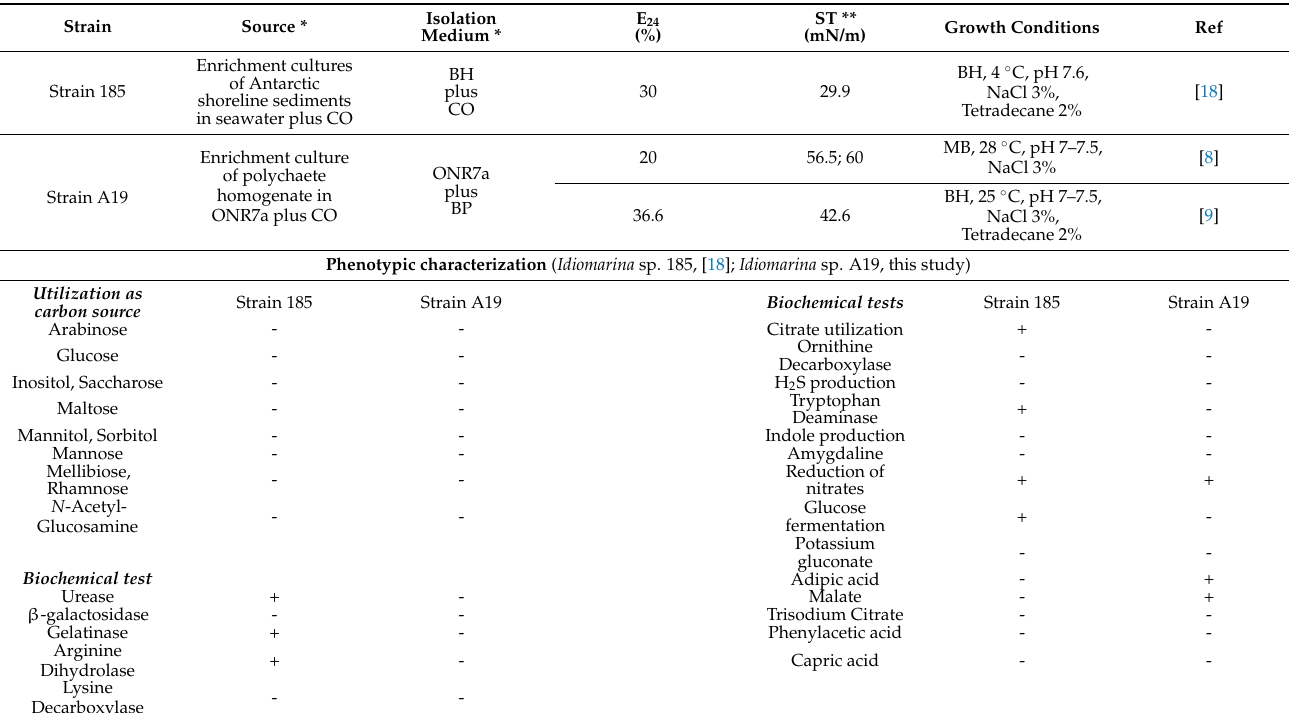
Table 1. Previous results on BS-producing Idiomarina isolates used in this